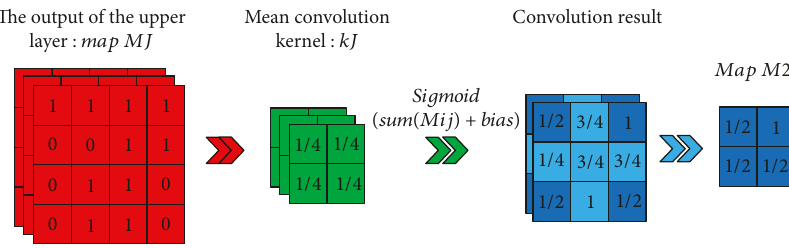
Figure 6: The schematic diagram of the pooling process.